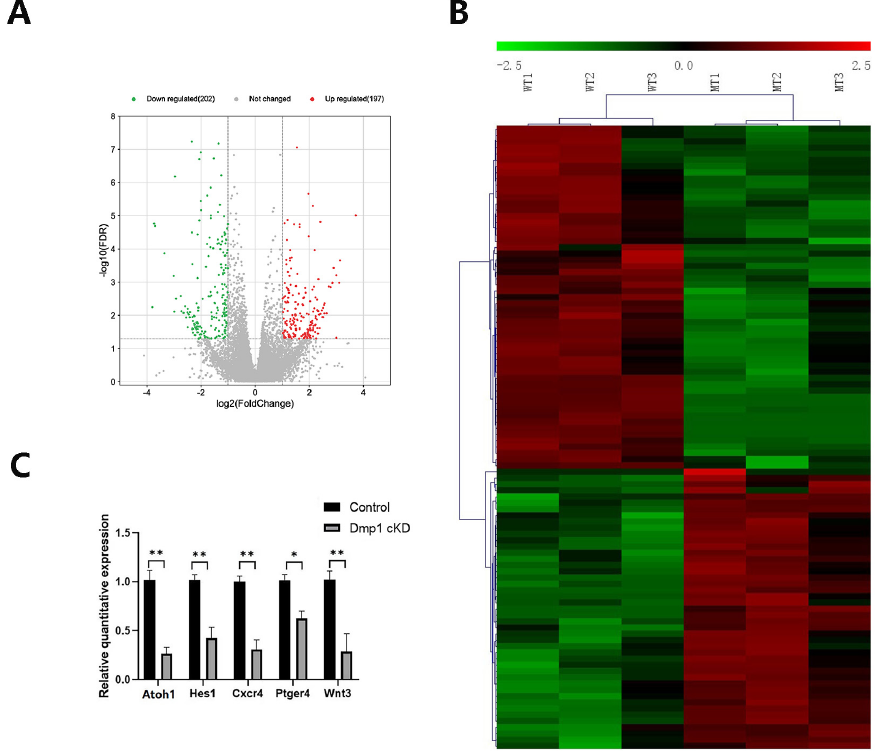
Figure 5. Transcriptomic change in Dmp1 − deficient cochlea. ( A ): The volcano plots of all DEGs. Statistically, a gene was considered differentially expressed if the fold change >2 and the adjusted p value < 0.05 (four dotted lines). Data points in red represent upregulated genes and green represent downregulated genes. ( B ): Heatmap generated by clustering 389 DEGs and 6 samples together. Red represents upregulated DEGs, while green represents downregulated DEGs. ( C ): qPCR validation of RNA ‐ Seq results showed that the expressions of Atoh1, Hes1, Cxcr4, Ptger4 and Wnt3 were significantly reduced in Dmp1 cKD cochleae. Data were expressed as mean ± SEM. n = 3; using t test, * p < 0.05 and ** p < 0.01. Table 2. Top 30 up ‐ or downregulated DEGs.